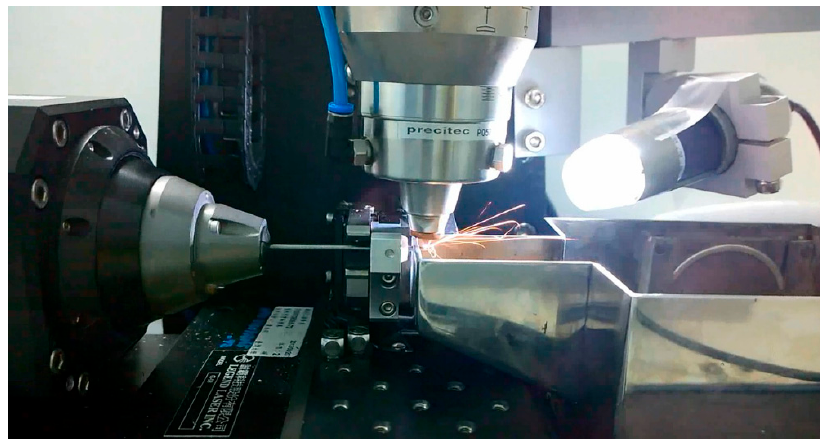
Figure 4. Cutting the design pattern of the spherical occlusion device onto a hypotube by laser.